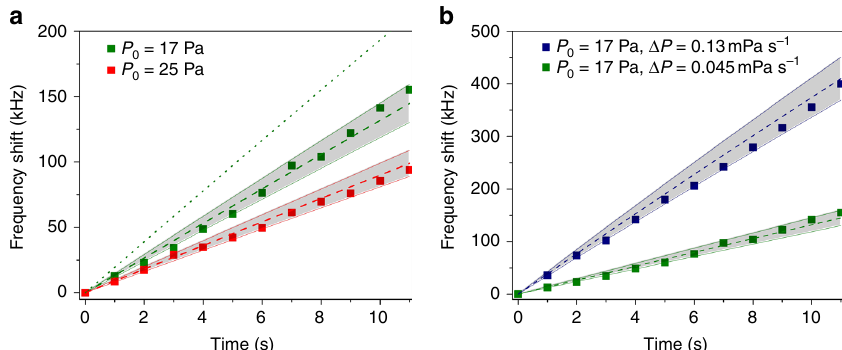
Fig. 2 Pressure dependence of the WGM resonance frequency shift. a The pressure in the vacuum chamber is slowly increased from 17 Pa ( olive ) and 25 Pa ( red ) with 45 mPa s − 1 . The frequency shift is measured by counting the beat frequency at every second while the laser is stabilized to the WGM resonator by Pound-Drever-Hall locking. To con fi rm the frequency shift by the pressure change, the theoretically estimated lines from Eq. (1) for TM mode ( dashed line ) and Eq. (2) for TE mode ( dotted line ) are plotted together. The measurement values agree with the theoretical model within the 10% error bars agree with the theoretical model. For comparison, the 10% error zones of the theoretical values are added ( gray ). b The pressure in the vacuum chamber